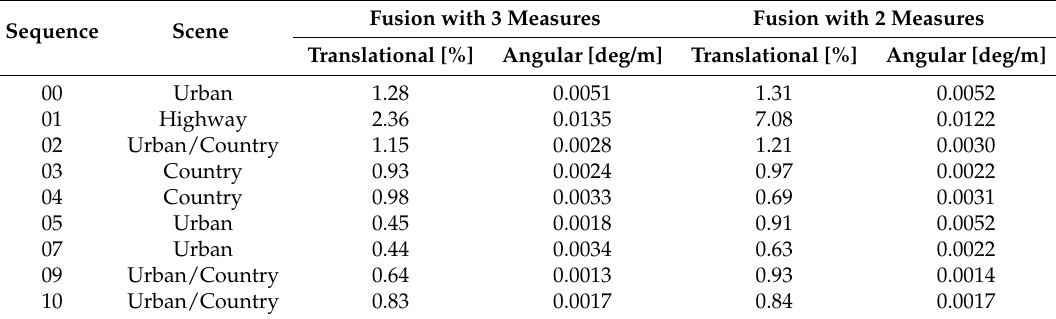
Table 3. Results of processed sequences with and without applying feature detection and SVD in the measurement fusion process.